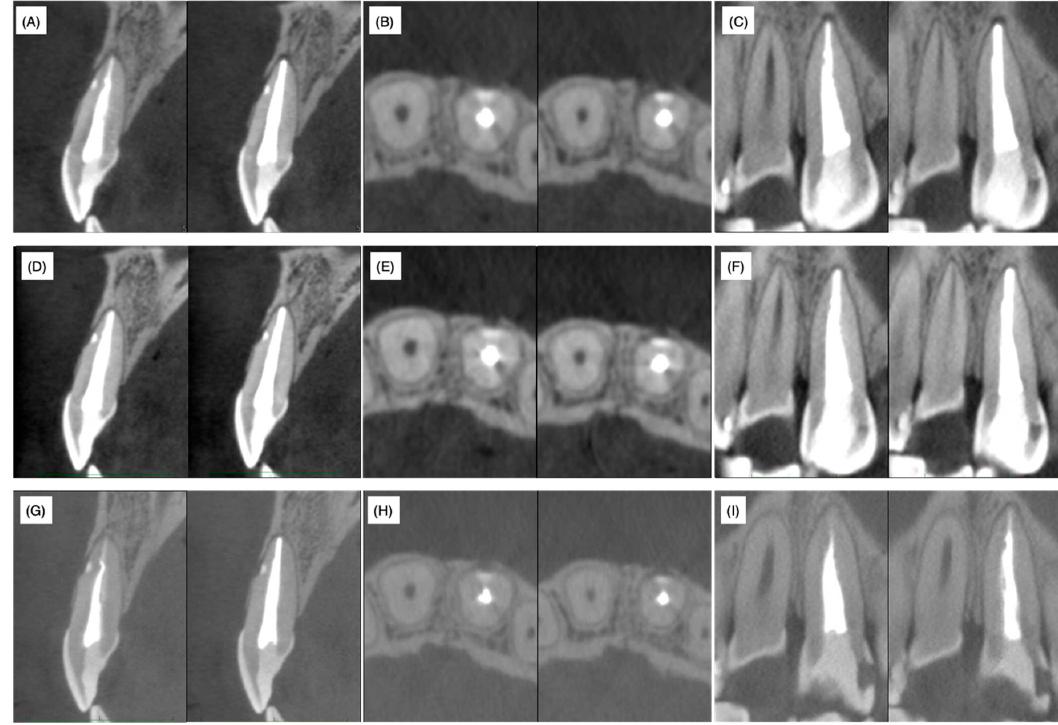
Figure 5. Cone-beam computed tomography images at three months ( A ) sagittal, ( B ) horizontal and ( C ) coronal; one year ( D ) sagittal, ( E ) horizontal and ( F ) coronal and two years ( G ) sagittal, ( H ) horizontal and ( I ) coronal after root filling.